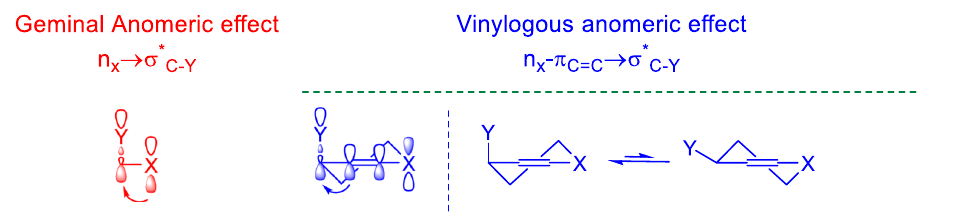
Figure 2. Geminal anomeric effect versus vinylogous anomeric effect 61